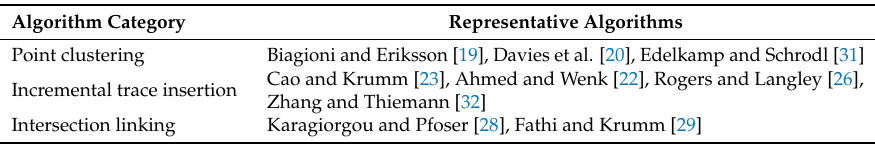
Table 1. Algorithm